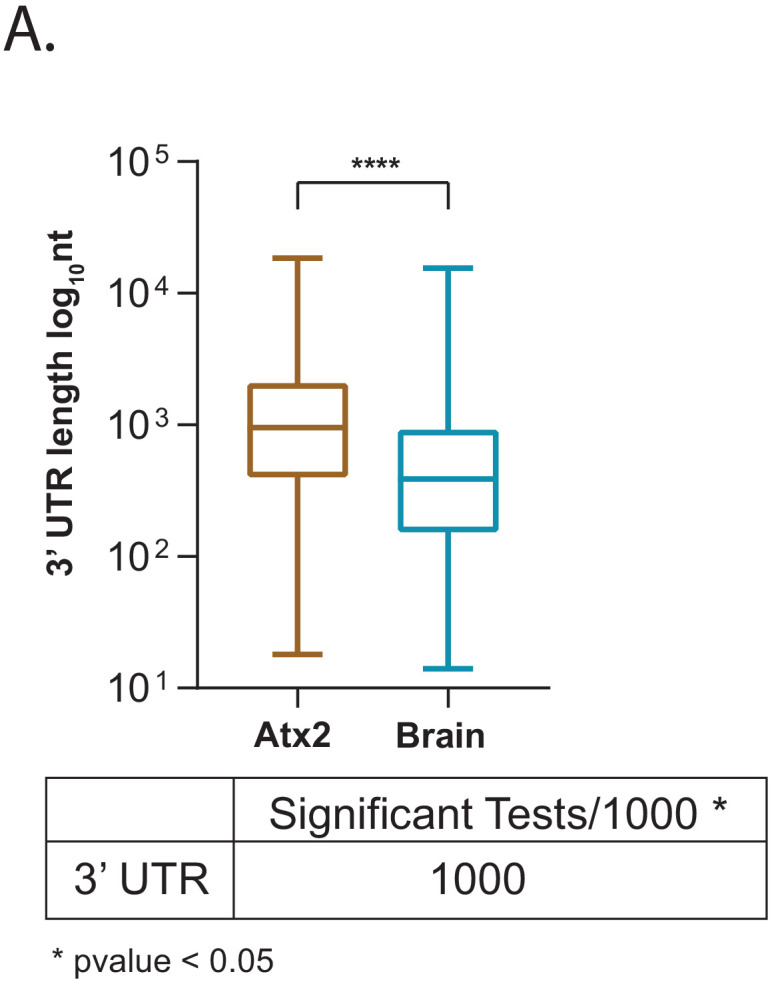
Atx2-target mRNAs have longer-than-average 3′UTRs.Mann–Whitney U test was used to determine the difference in the 3′UTR length between Atx2 targets and brain transcriptome. p-Value is <0.0001, and error bars represent SEM. Bootstraping was performed 1000 times with replacement. Statistics was performed using chi-square test with cutoff (p-value <0.05). Fisher's test was used to combine the p-values.